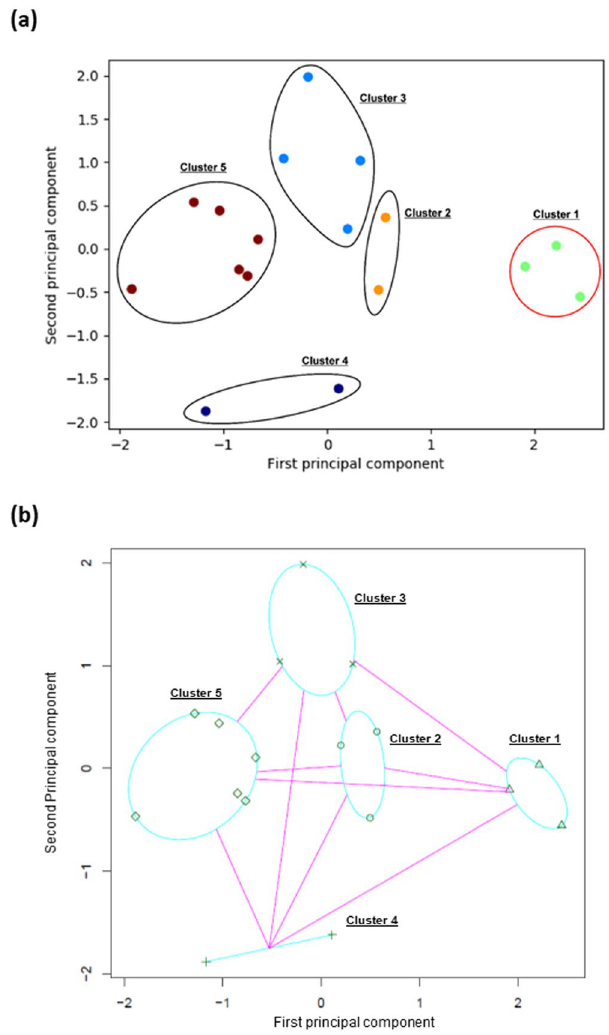
Figure 1. A graphical representation of the affinity propagation ( a ) and k-medoids ( b ) clustering results using principal component analysis. The affinity propagation (AP) analysis showed good classifying of potential vitamin B6-responsive persons with ASD (cluster 1). All the participants were relatively well classified into five groups, and clusters 2 to 5 consisted of persons who exhibited a low response to vitamin B6. A graphical representation of the AP clustering results using principal component analysis (PCA) is presented in 1a . The k-medoids analysis also showed good classification . The selected number of clusters by k-medoids was also five and the result was identical to that by the AP except for one participants who was classified in Cluster 2 by the AP was classified in Cluster 3 by the k-medoids method. A graphical representation of the k-medoids clustering results using PCA is presented in 1b